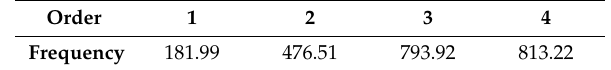
Figure 1. Pipe substructure number. Table 2. The first four natural Table 1. Pipe parameters.